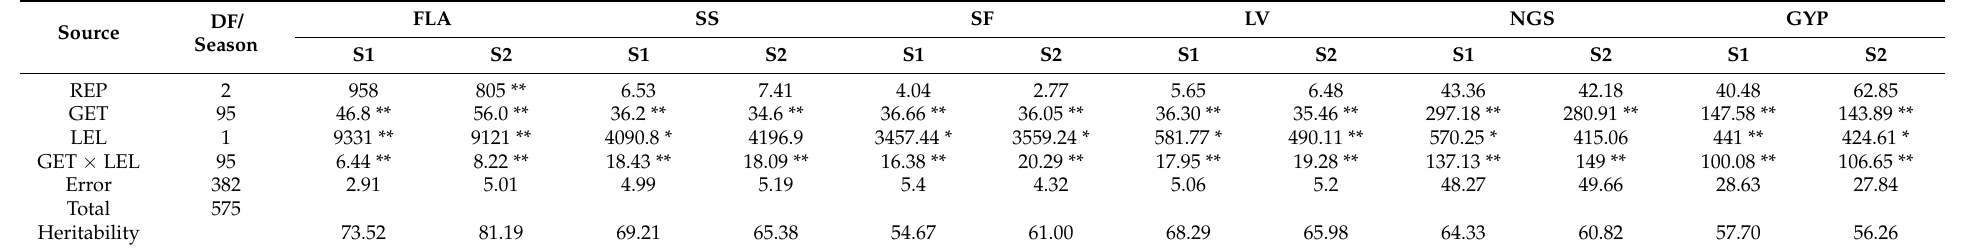
Table 1. Mean sum of squares of 96 spring wheat genotypes for studied attributes under both seasons, data averaged over